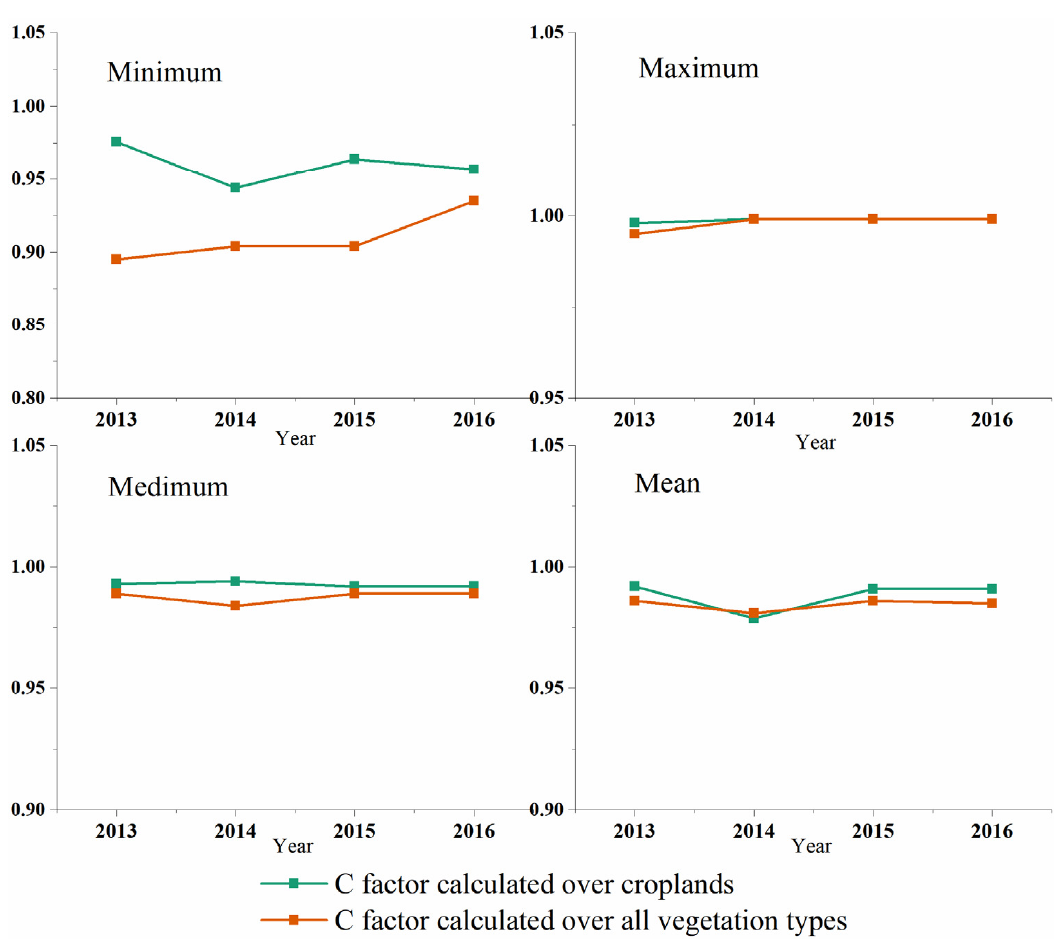
Figure 8. The minimum, maximum, median, and average values of C factors calculated over croplands and all vegetation types, respectively, in the SSEBop model.